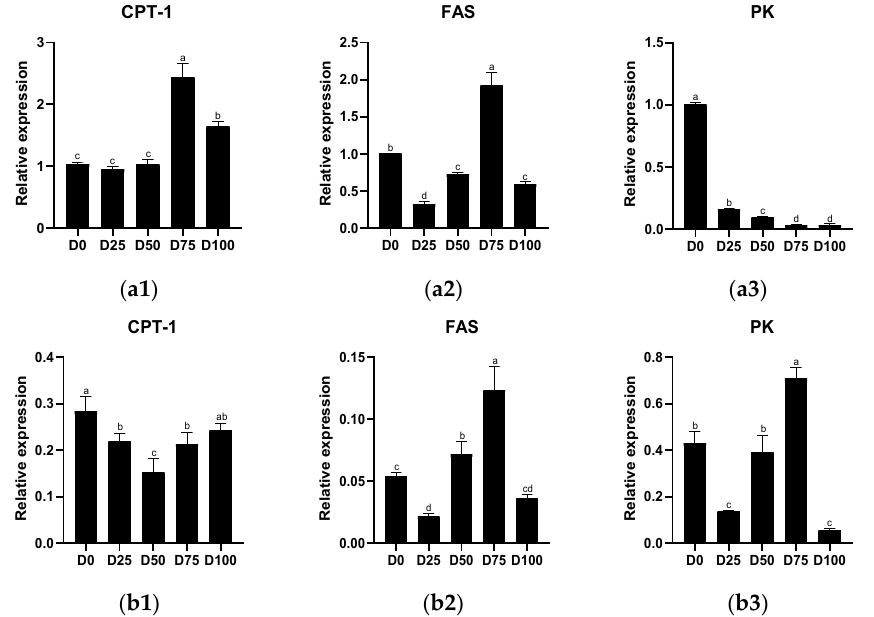
Figure 2. The effects of eugenol on the relative expression of CPT-1, FAS, PK in liver ( a1 – a3 ) and gill ( b1 – b3 ) tissue of greater amberjack under simulated transport conditions. Different letters above bars indicate significant differences at the 0.05 level.